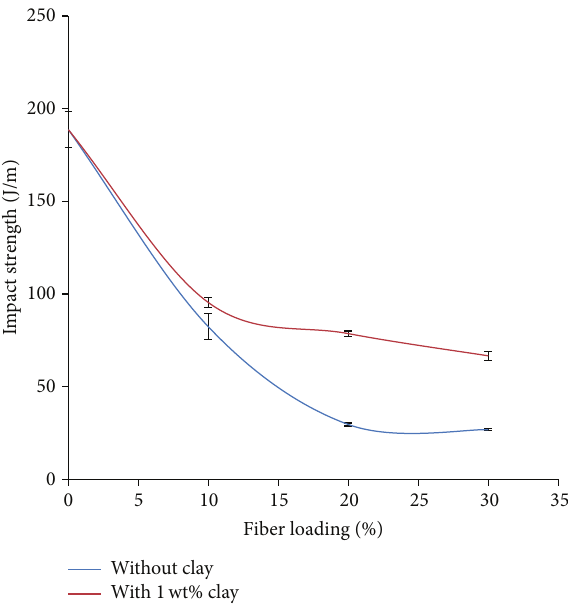
Figure 3: Flexural modulus of PLA/PCL/OPMF biocomposites and PLA/PCL/1wt% clay/OPMF hybrid composites.